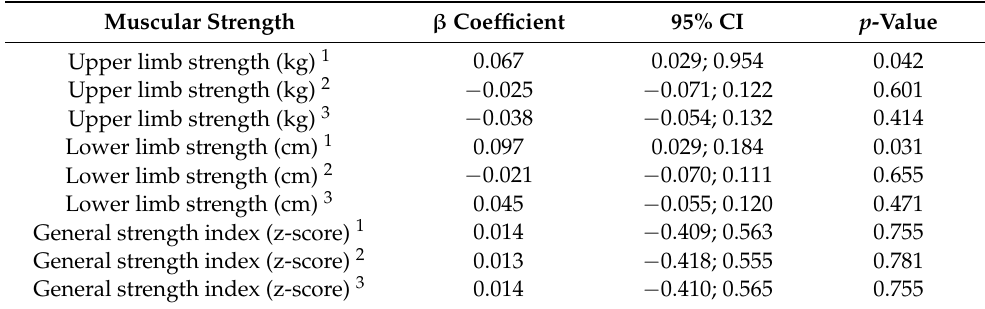
Table 4. Adjusted analyses between the muscular strength of upper and lower limbs and self-esteem in 9-year old Chilean girls: independent association with body composition indicators. Muscular Strength β Coefficient 95% CI p